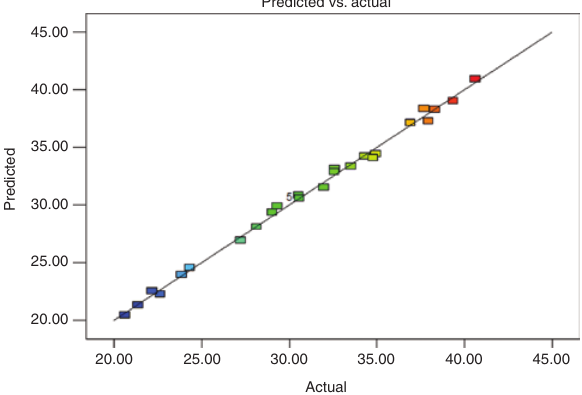
Figure 4: The relationship between the predicted and experimental